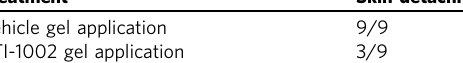
Table 1 VTI-1002 gel treatment inhibits skin fragility in BP murine model 48 h after the BP-IgG injection. Skin fragility in vehicle or VTI-1002 gel-treated mice was tested for Nikolsky ’ s sign by gently rubbing their fl anks three times.